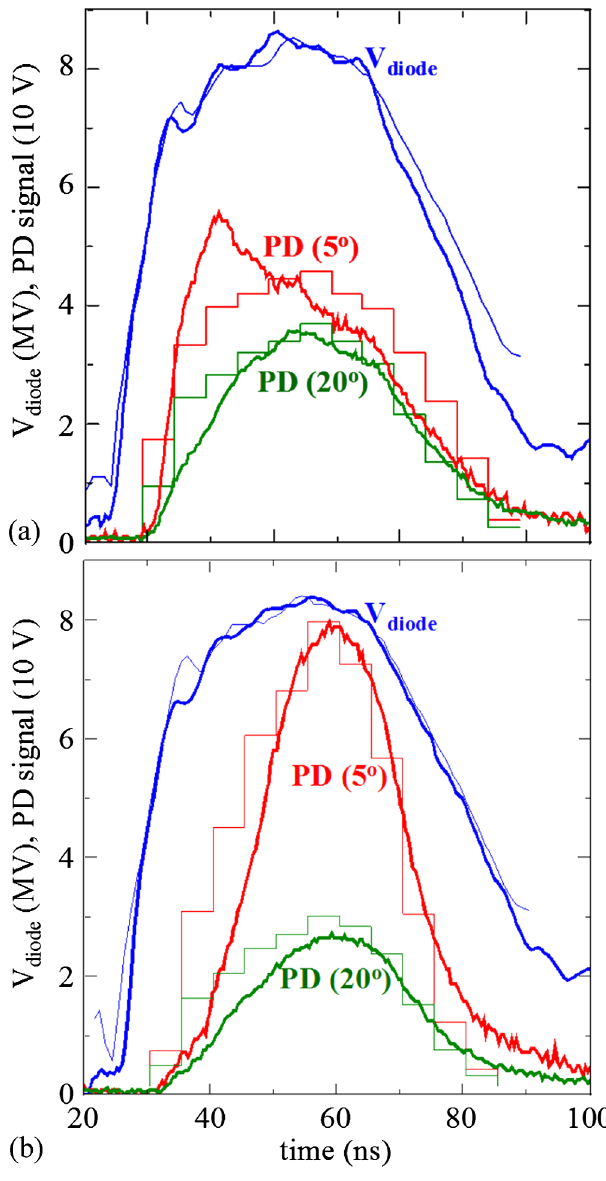
FIG. 11. (a) Time-dependent photodiode measurements and LSP/ITS computations for a 23 cm AK gap. Measured diode voltage and photodiode traces for shot 1330 are bold curves. The finer voltage curves and PD histograms are computed from LSP/ ITS. (b) Time-dependent photodiode measurements and LSP/ITS computations for a 40 cm AK gap. The same quantities are plotted for shot 1295 as in Fig.